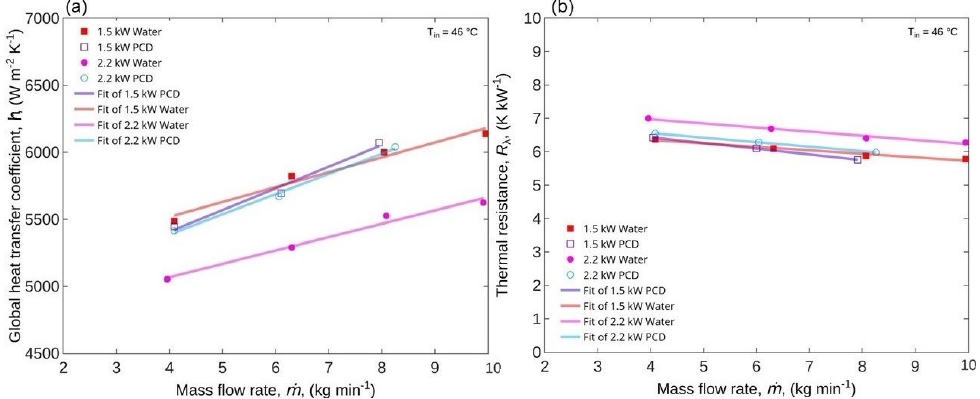
Figure 7. ( a ) The global heat transfer coefficients for water and the PCD against the mass flow rate, calculated with Equation (5) for electrical heating inputs of 1.5 and 2.2 kW, ( b ) the thermal resistances for water and the PCD against the mass flow rate as calculated by Equation (8) for electrical heating inputs of 1.5 and 2.2